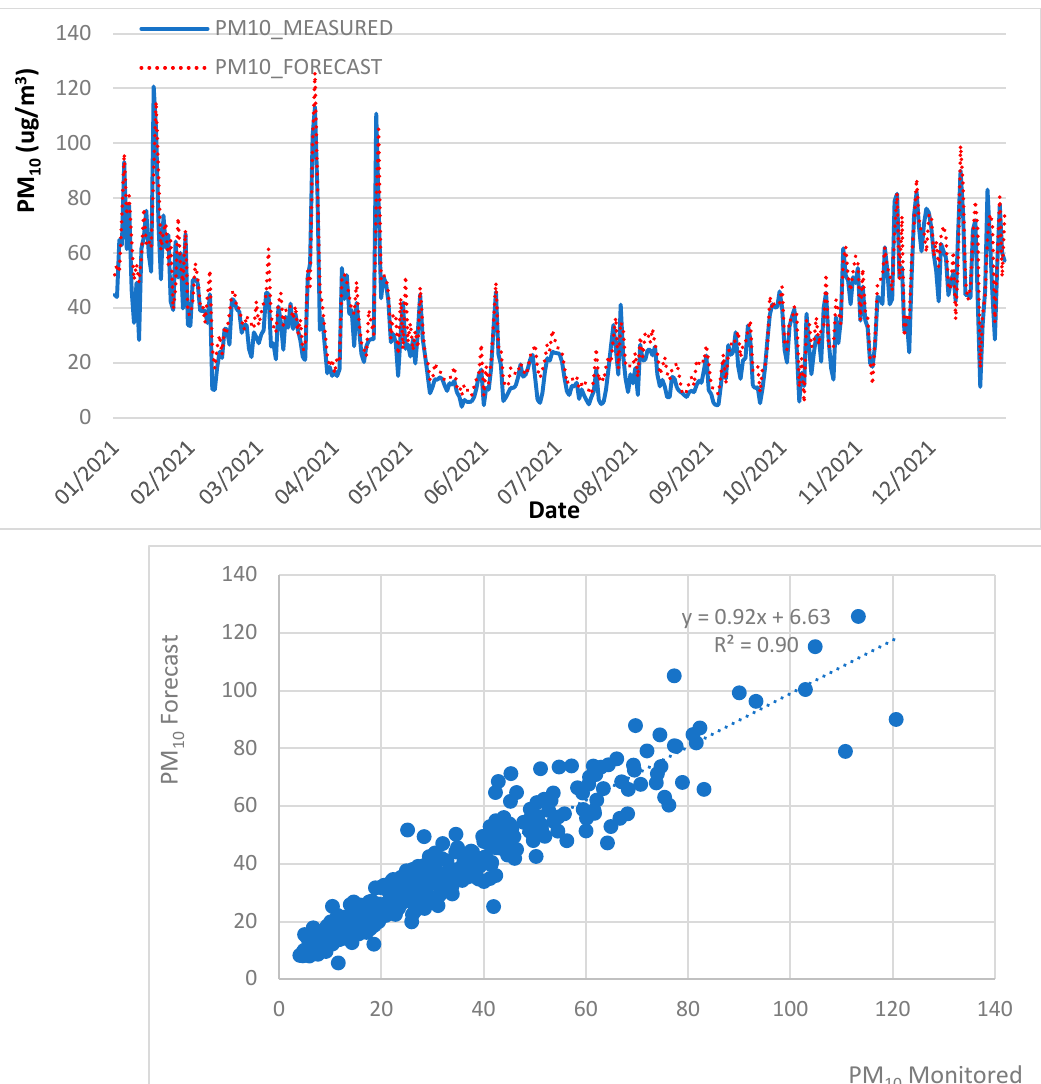
Figure 6. Observed and predicted PM 10 concentrations using MLR in 2021.